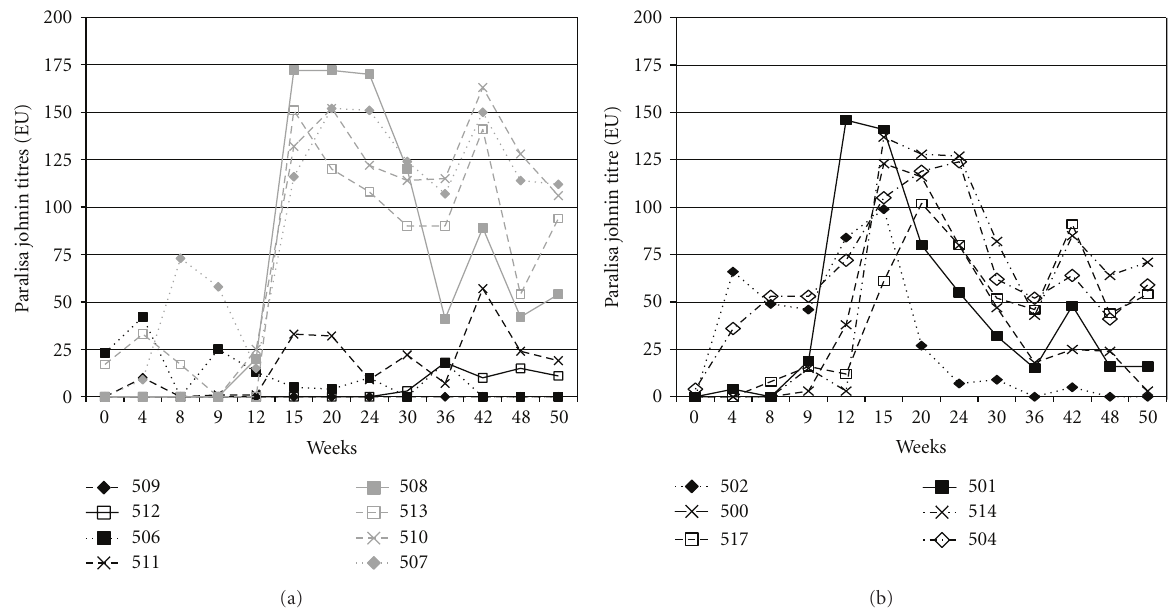
Figure 1: (a) Paralisa titres (PPA antigen) in ELISA units (EU) over the 50 week study for the four deer (506, 509, 511, 512) that had the lowest serological response to the Paralisa Johnin antigen (black lines), and the four deer (507, 508, 510, 513) that had the highest and most sustained serological response to Johnin (gray lines). (b) Paralisa titres (PPA antigen) in ELISA units (EU) over the 50 week study for the six deer that had an intermediate serological response to the Paralisa Johnin